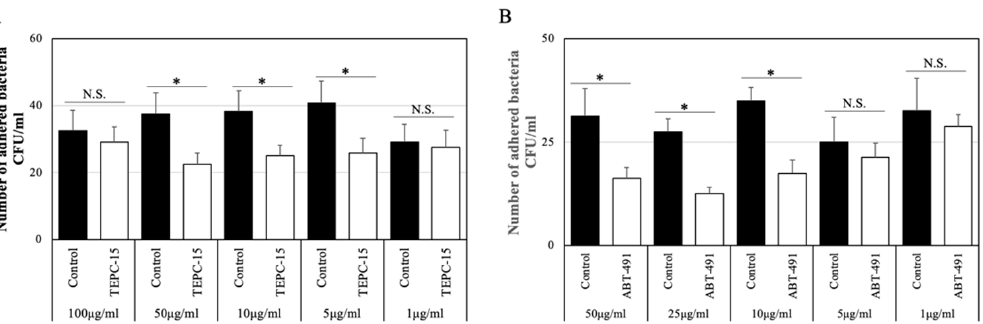
Figure 1. Adhesion inhibitory effect at concentrations of TEPC-15 and ABT-491. In TEPC-15, bacterial adhesion was significantly suppressed at 50, 10, and 5 μ g/mL ( p < 0.05). ( A ) In ABT-491, bacterial adhesion was significantly suppressed at ≥ 10 μ g/mL ( p < 0.05). ( B ) Error bars indicate the standard deviation of the mean ( n = 5). * p ≤ 0.05.